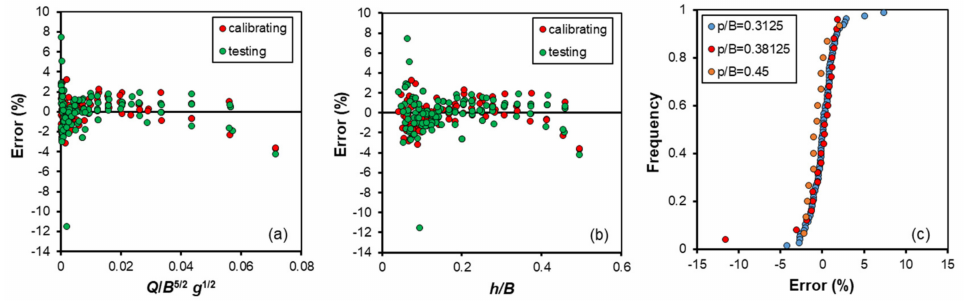
Figure 10. Relationships between the errors Er in the discharge estimate obtained by Equation (23) and the main characteristics of the investigated data Q / B 5/2 g 1/2 ( a ), h / B ( b ), and p / B ( c ). In conclusion, Equation (23) allows reducing, in comparison with Equation (22), the errors in the estimate of the discharge for triangular broad-crested weirs with p / B > 0 and for Equation (23), the errors are independent of the main characteristics ( Q / B 5/2 g 1/2 , h / B